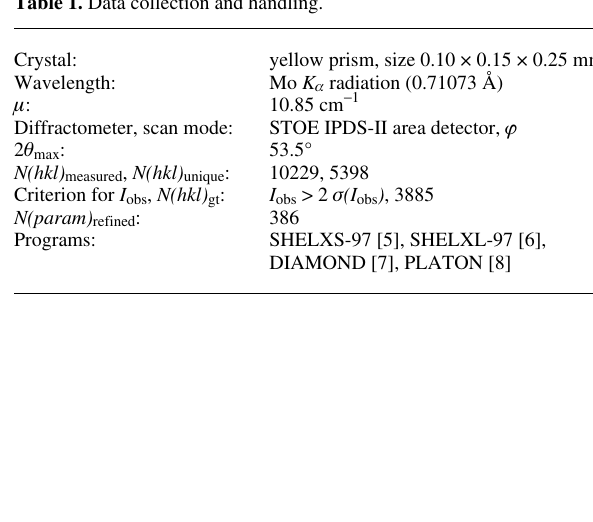
Table 3. Atomic coordinates and displacement parameters (in Å 2 ) . Atom Site Occ.